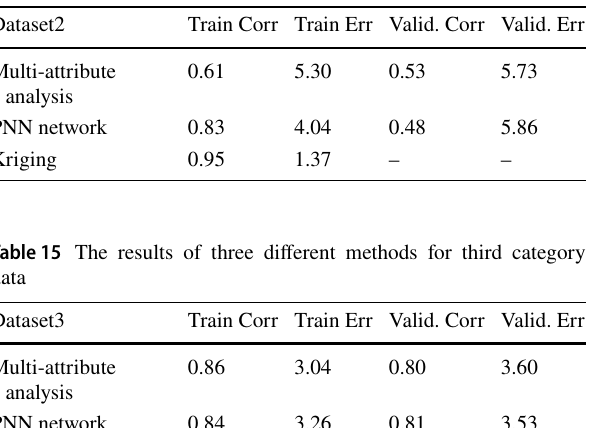
Table 14 The results of three different methods for second category data